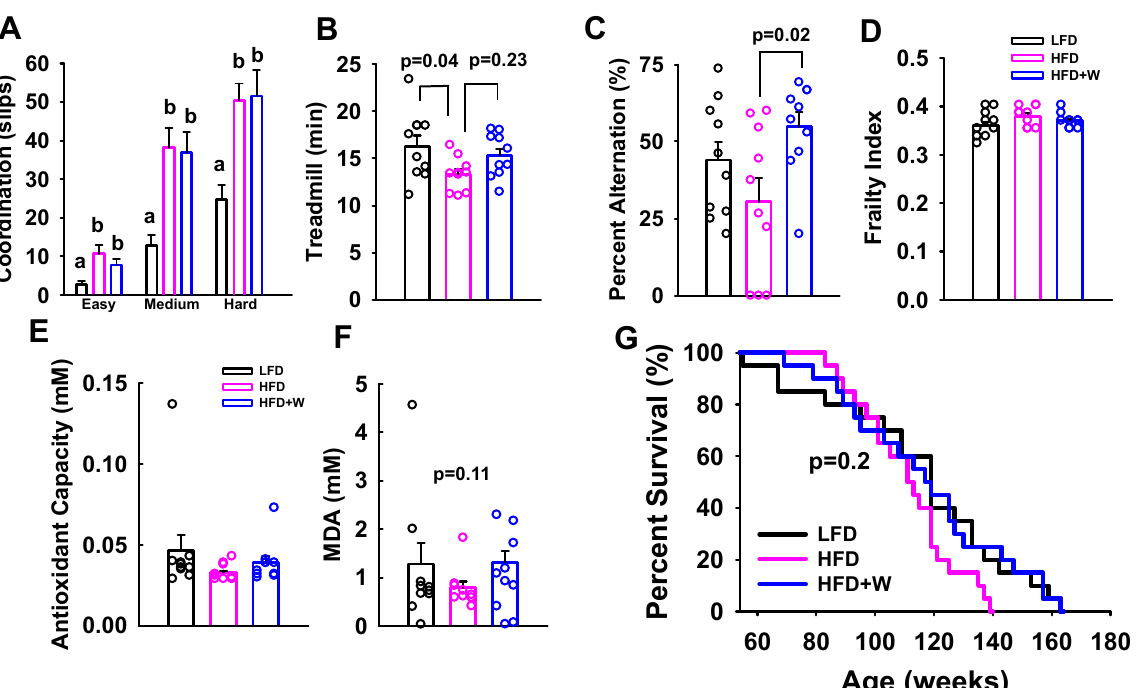
Figure 2. Effect of dietary walnuts on healthspan and lifespan in HFD-fed male CB6F1 mice. ( A ) When subjected to balance beam, LFD animals demonstrated the fewest number of slips on all three beams of varying difficulty, while the number of slips was similarly and significantly increased in both cohorts of HFD-fed animals ( n = 10 per group for all tests) ( B ) Exercise capacity was also evaluated using a modified motorized treadmill, and revealed that voluntary exhaustion was significantly worsened in HFD mice, as compared to LFD ( p = 0.04), though exercise capacity tended to be greater in HFD + W versus HFD ( p = 0.23 after Tukey adjustment), and was comparable to LFD performance ( p = 0.73). tended to decline in HFD versus LFD mice, HFD + W animals demonstrated a marked and significant improvement in working memory versus HFD controls ( p = 0.02). ( D ) Frailty scores, as determined by a 31-point preclinical frailty index, did not detect any significant differences among groups. In plasma, we further assessed antioxidant capacity and the lipid peroxidation marker, ( E , F ) MDA, but did not observe any significant differences in these measures among groups. ( G ) Furthermore, no significant overall effect was observed on survival from 12 mo of age ( p = 0.2) among groups ( n = 20 per group). Bar graphs represent mean ± SE. Dot plots overlaid on bar graphs represent individual data points. Different letters denote a significant difference between groups after Tukey HSD adjustment. Exact p -values for treadmill and Y-maze indicate significant levels between groups with Tukey HSD adjustment, the ANOVA test for MDA, and log-rank test,